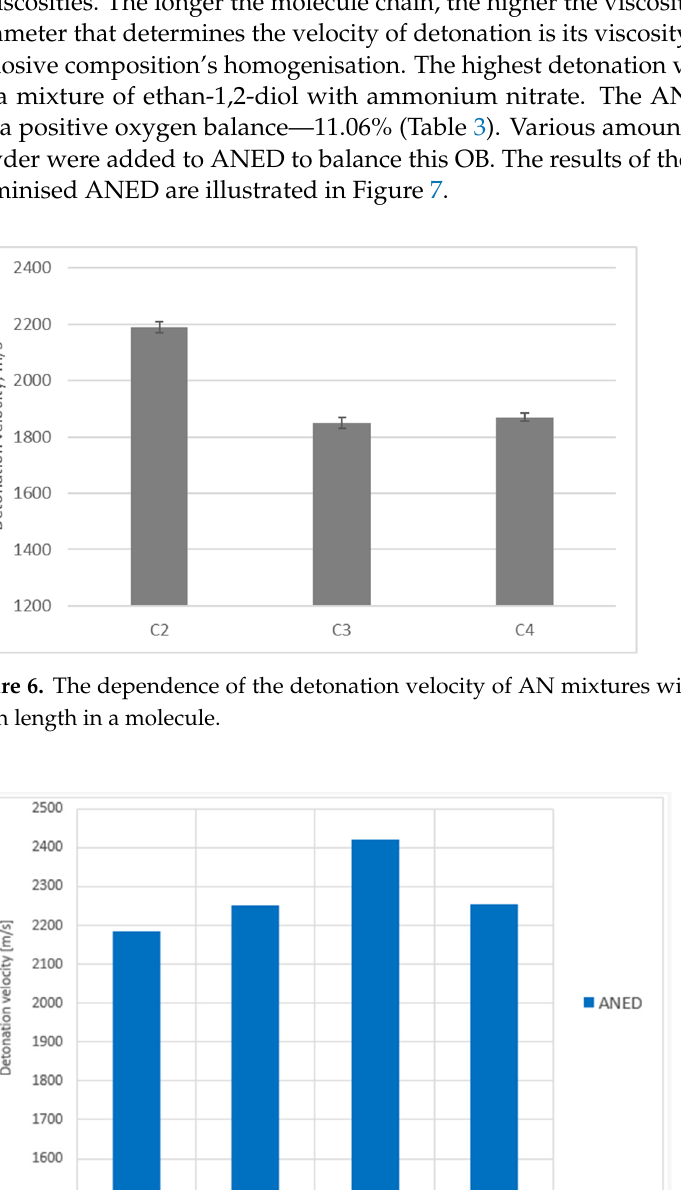
Figure 7. Dependence of detonation velocity of AN/fuel mixtures on the content of aluminium